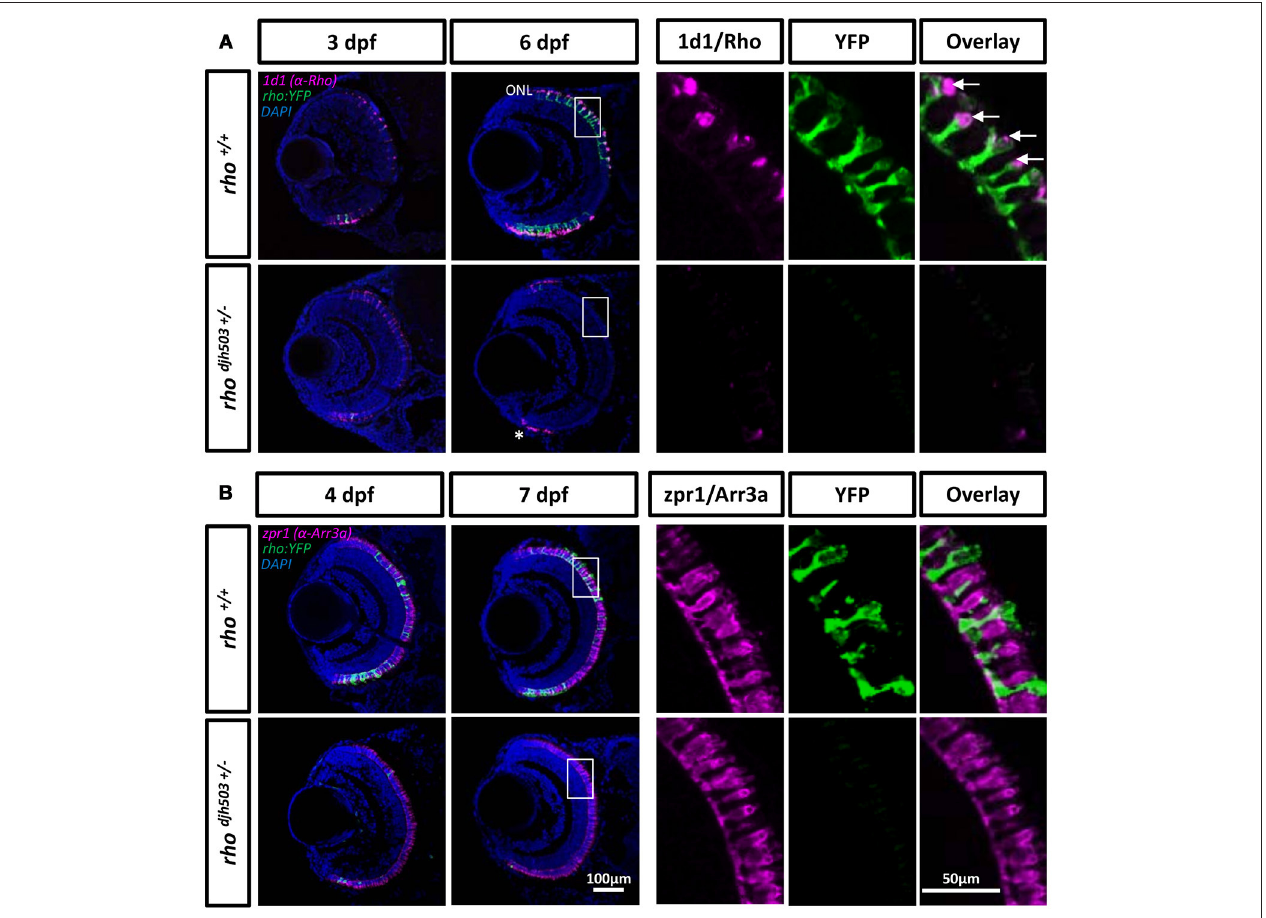
FIGURE 3 | Rod but not cone photoreceptors are reduced in rho djh503 + / − mutants. (A) The 1d1 antibody (magenta), which recognizes Rhodopsin , labels the outer segments of wildtype rod cells. The labeling pattern is similar in both wildtype and mutants at 3 dpf. At 6 dpf, 1d1 antibody labeling is restricted to the proliferating marginal zone in rho djh503 + / − mutants (*), but remains throughout the ONL in wildtype retinas. The white boxed region in the 6 dpf images are enlarged in the panels to the right showing that the 1d1 antibody labels YFP-expressing rod cells (green, arrows). (B) The zpr1 (magenta) antibody labeled cone cells do not show an obvious difference between wildtype and mutant retinas at 4 and 7 dpf. The boxed region in the 7 dpf images is enlarged to the right showing no overlay between zpr1 antibody staining and YFP-expressing rod cells (green). DAPI (blue) was used to stain cell nuclei. Arr3a, Arrestin 3a; DAPI, 4 ′ ,6-diamidino-2-phenylindole; dpf, days post-fertilization; ONL, outer nuclear layer; rho, rhodopsin ; Rho, Rhodopsin; YFP, yellow fluorescent